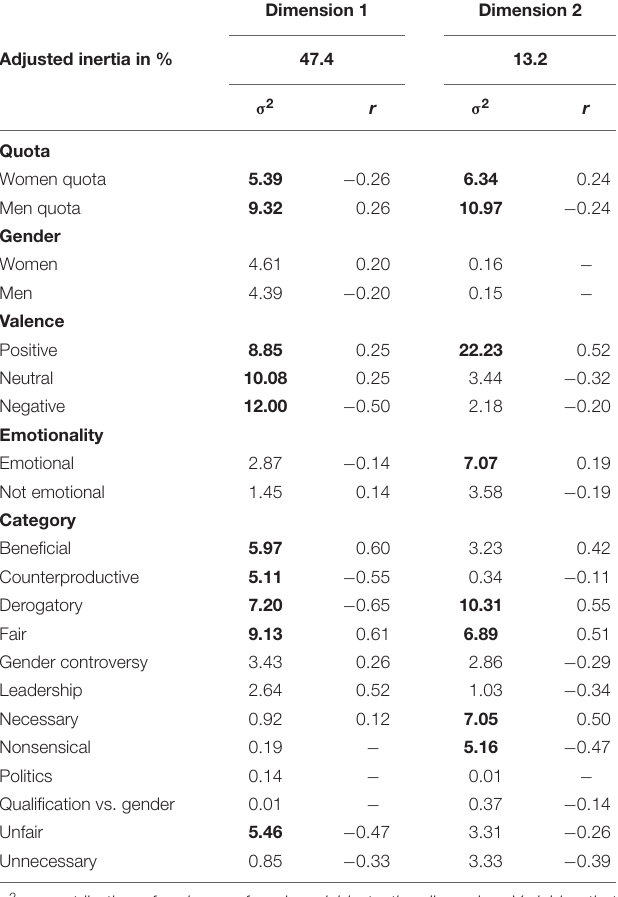
TABLE 6 | Description of the two dimensions extracted in the multiple correspondence